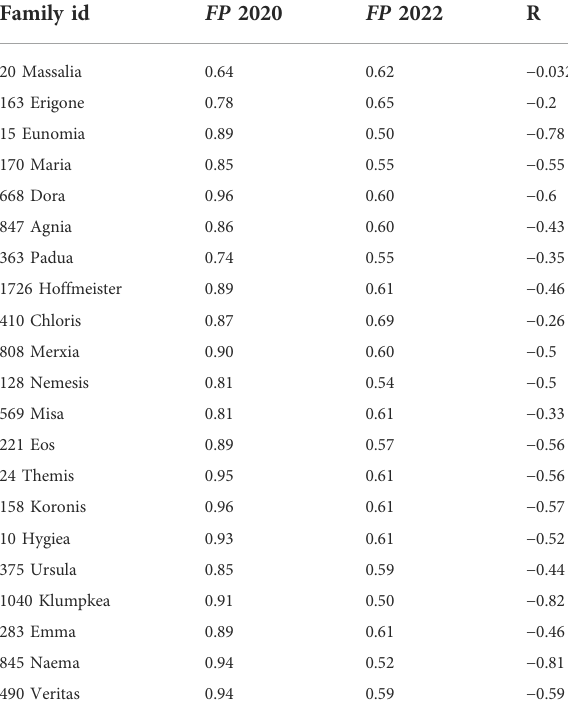
TABLE 3 Table reports the metrics of the 21 asteroid families from the Asteroid Families Portal using provided genetic machine learning algorithm by TPOT . There is a representation of the metrics f 1 (completeness), precision, the FP coef fi cients, and the best estimator of each